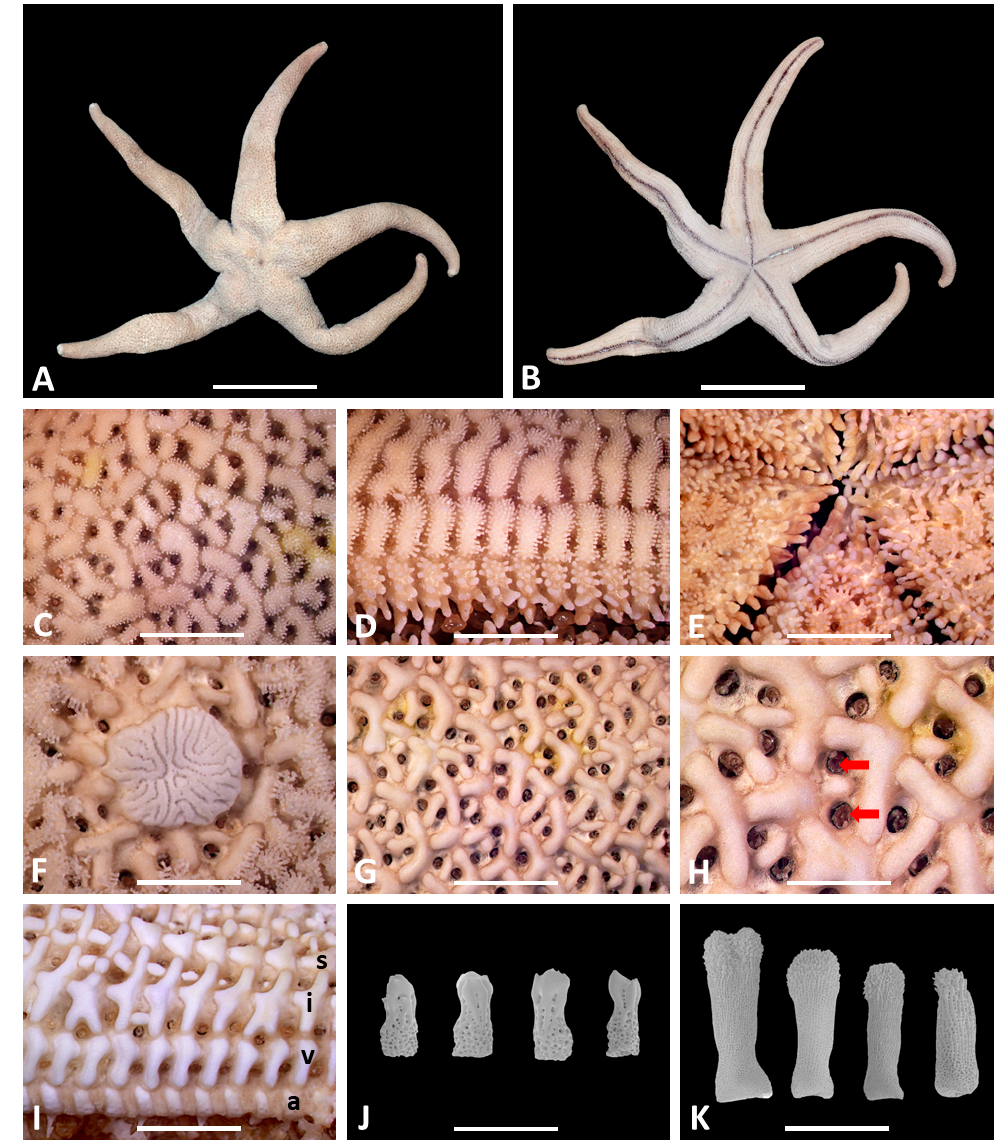
Figure 1. Henricia djakonovi Chichvarkhin, 2017. ( A ). abactinal side; ( B ). actinal side; ( C ). abactinal paxillae; ( D , K ). adambulacral spines; ( E ). oral part; ( F ). madreporite; ( G ). abactinal skeleton; ( H ). papulae (arrows); ( I ). actinal skeleton: superomarginal plates (s); inferomarginal plates (i), ventrolateral plates (v), adambulacral plates (a); and ( J ). abactinal spines. Scale bars: A, B = 2 cm, C–I = 1 mm, J = 100 µm, K = 500 µm (J, K, SEM images).